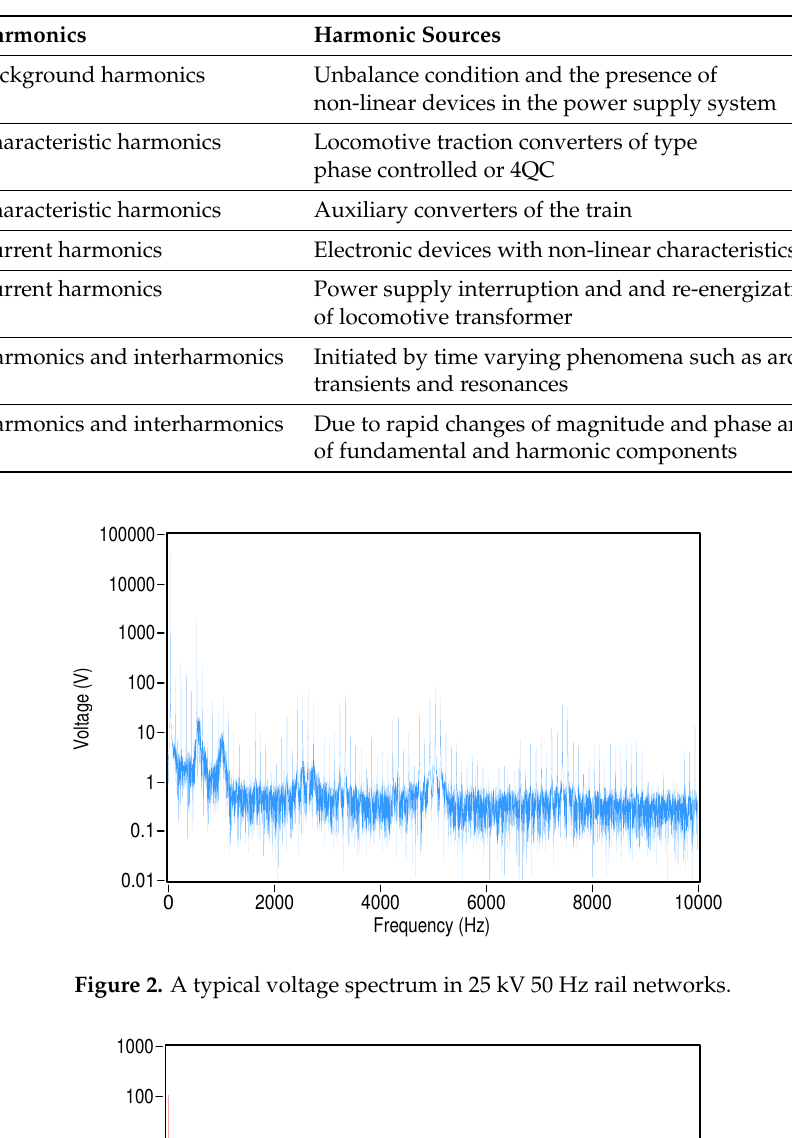
Table 1. Harmonic sources in 25 kV 50 Hz railway systems.